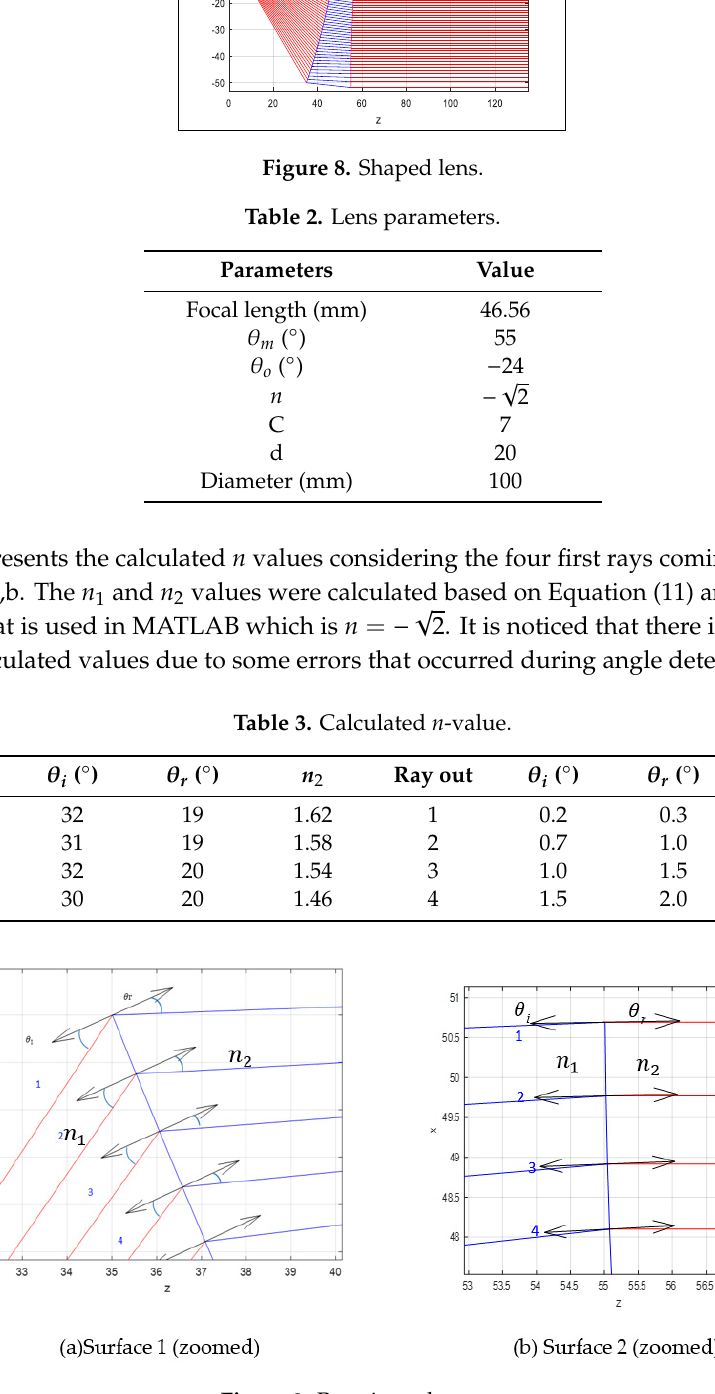
Figure 7. Comparison of aperture distribution . Considering all the design parameters stated previously, the shaped lens was obtained as illustrated in Figure 8. For the designed lens in Figure 8, the accuracy of the MATLAB program was validated by calculating the incident angle, 𝜃 𝑖 and refracted angle,